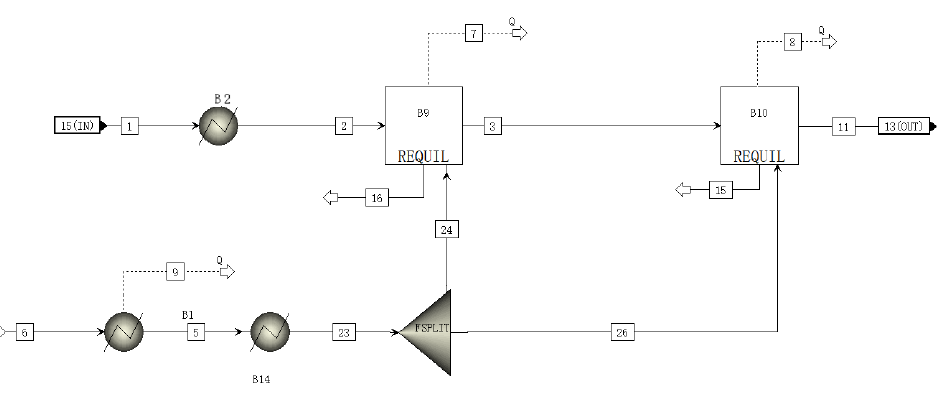
Figure 2. A schematic of the SHIFT module flowsheet.